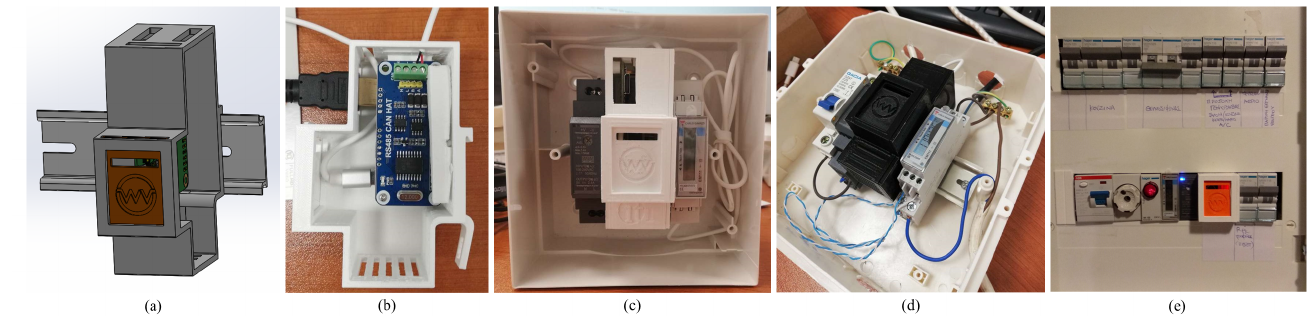
Figure 8. ODRes Remote Metering Solution : ( a ) the design of the 3D-printed custom casing; ( b ) the Raspberry Zero installation of ODRes within the casing; ( c – d ) the automatic relay (left), the ODRes Raspberry Zero (centre), the Carlo Gavazzi Smart Meter (right); ( e ) the final integrated ODRes remote metering solution in a house fuse box.